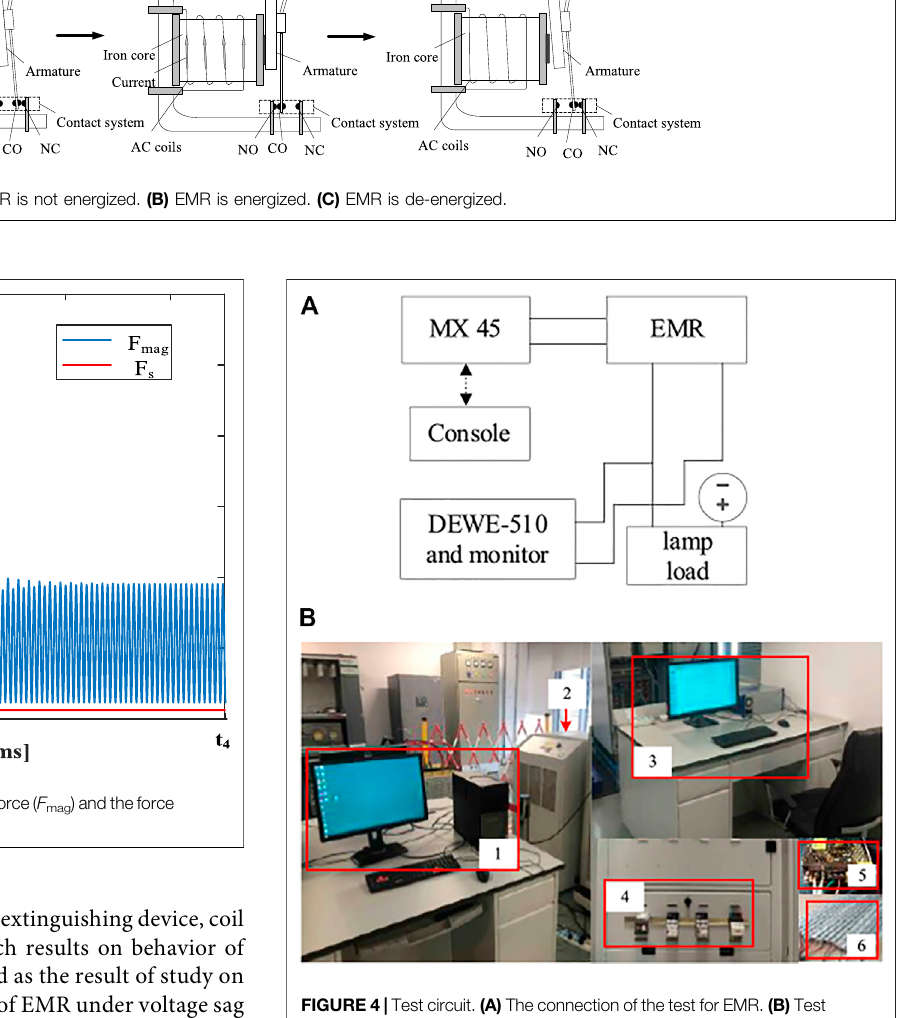
FIGURE 4 | Test circuit. (A) The connection of the test for EMR. (B) Test platform (1. console, 2. programmable power supply (MX45), 3. data acquisitiondeviceDEWE-510anditsDisplay,4.EMR,5.DCsupplysource,6. lamp load).